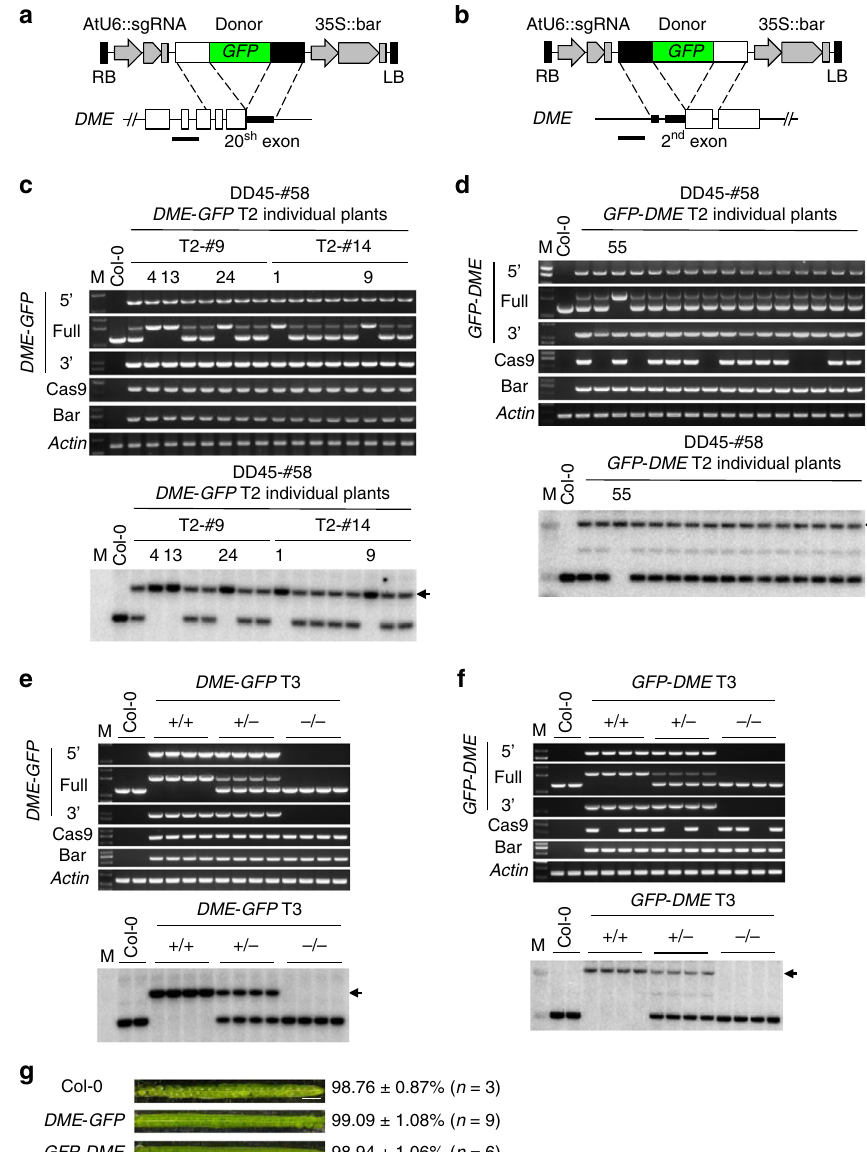
Fig. 3 GFP knock-in into the endogenous DME locus by gene targeting. a , b Schematics showing HDR donor transgene constructs and part of the targeted DME locus for DME - GFP and GFP - DME knock-in, respectively. The horizontal lines indicate the positions of probes for Southern blotting. c − f Genotyping PCR and Southern blotting for individual T2 lines ( b ) and T3 plants ( e ) of DME - GFP , respectively. Arrow indicates the band of DME - GFP from gene targeting (see Supplementary Figure 3). Genotyping PCR and Southern blotting for individual T2 lines ( d ) and T3 plants ( f ) of GFP - DME , respectively. Arrow indicates the band of GFP - DME from gene targeting (see Supplementary Figure 3). g Analysis of seed abortion. Seeds from Col-0, homozygous DME - GFP , and GFP - DME knock-in T3 plants were analyzed. Scale bar, 1 mm. All PCR primers are as depicted in Supplementary Figure 3 and Supplementary Table